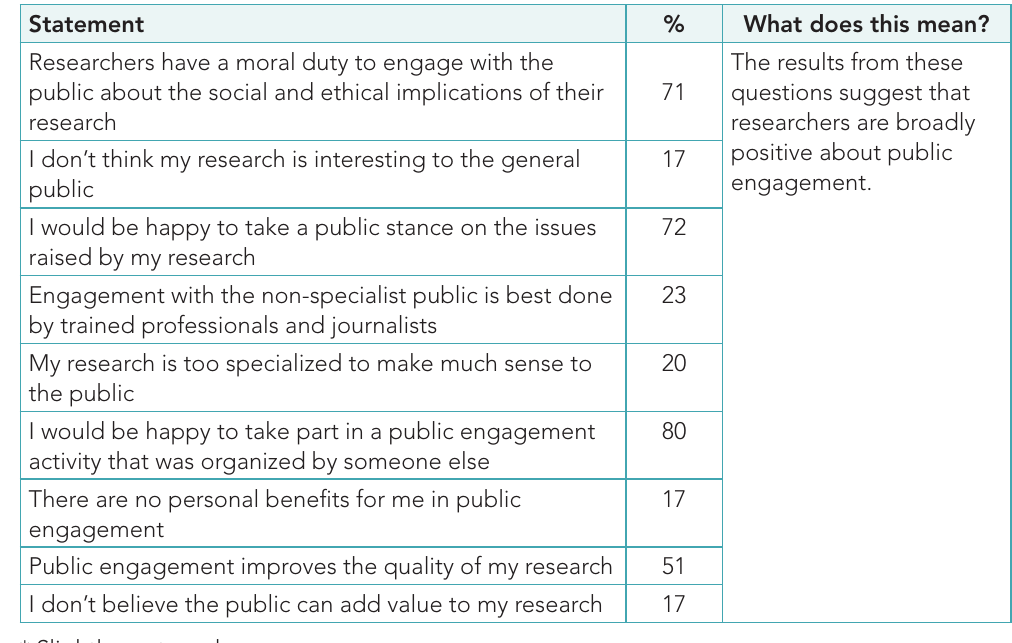
Table 4: Agreement* with attitudinal statements